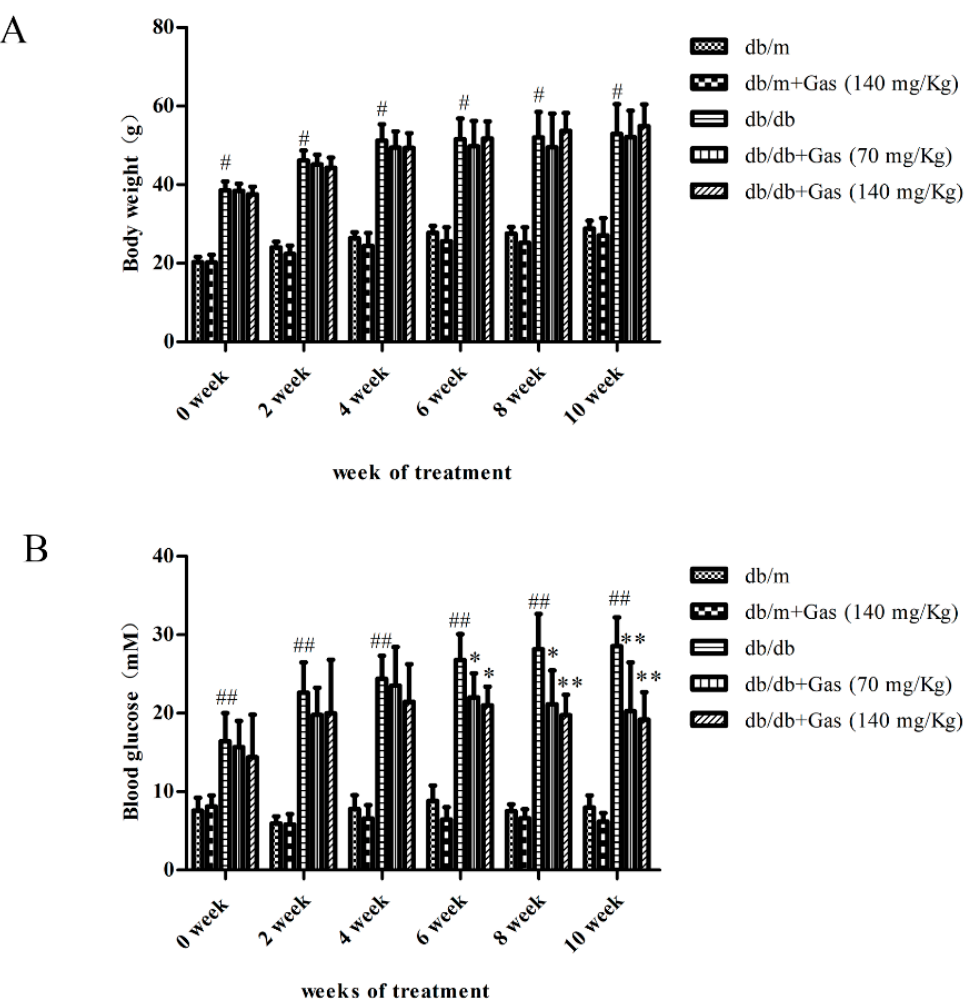
Figure 3. Effects of Gastrodin (Gas) on body weight and fasting blood glucose of db/db mice. ( A ) Body weight of mice in each group during 12 weeks of treatment. ( B ) Fasted blood glucose level of mice in each group during 12 weeks of treatment. # p < 0.05, ## p < 0.01, compared with the db/m group. * p < 0.05, ** p < 0.01, compared with the db/db group.